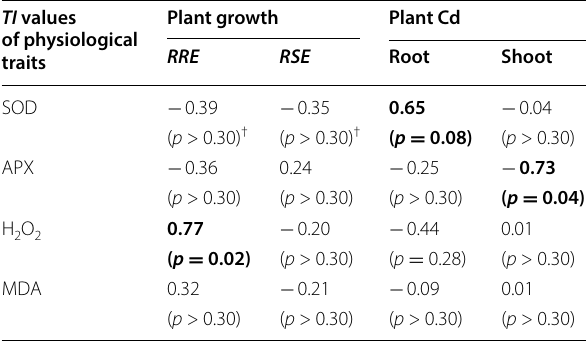
coefficients between the